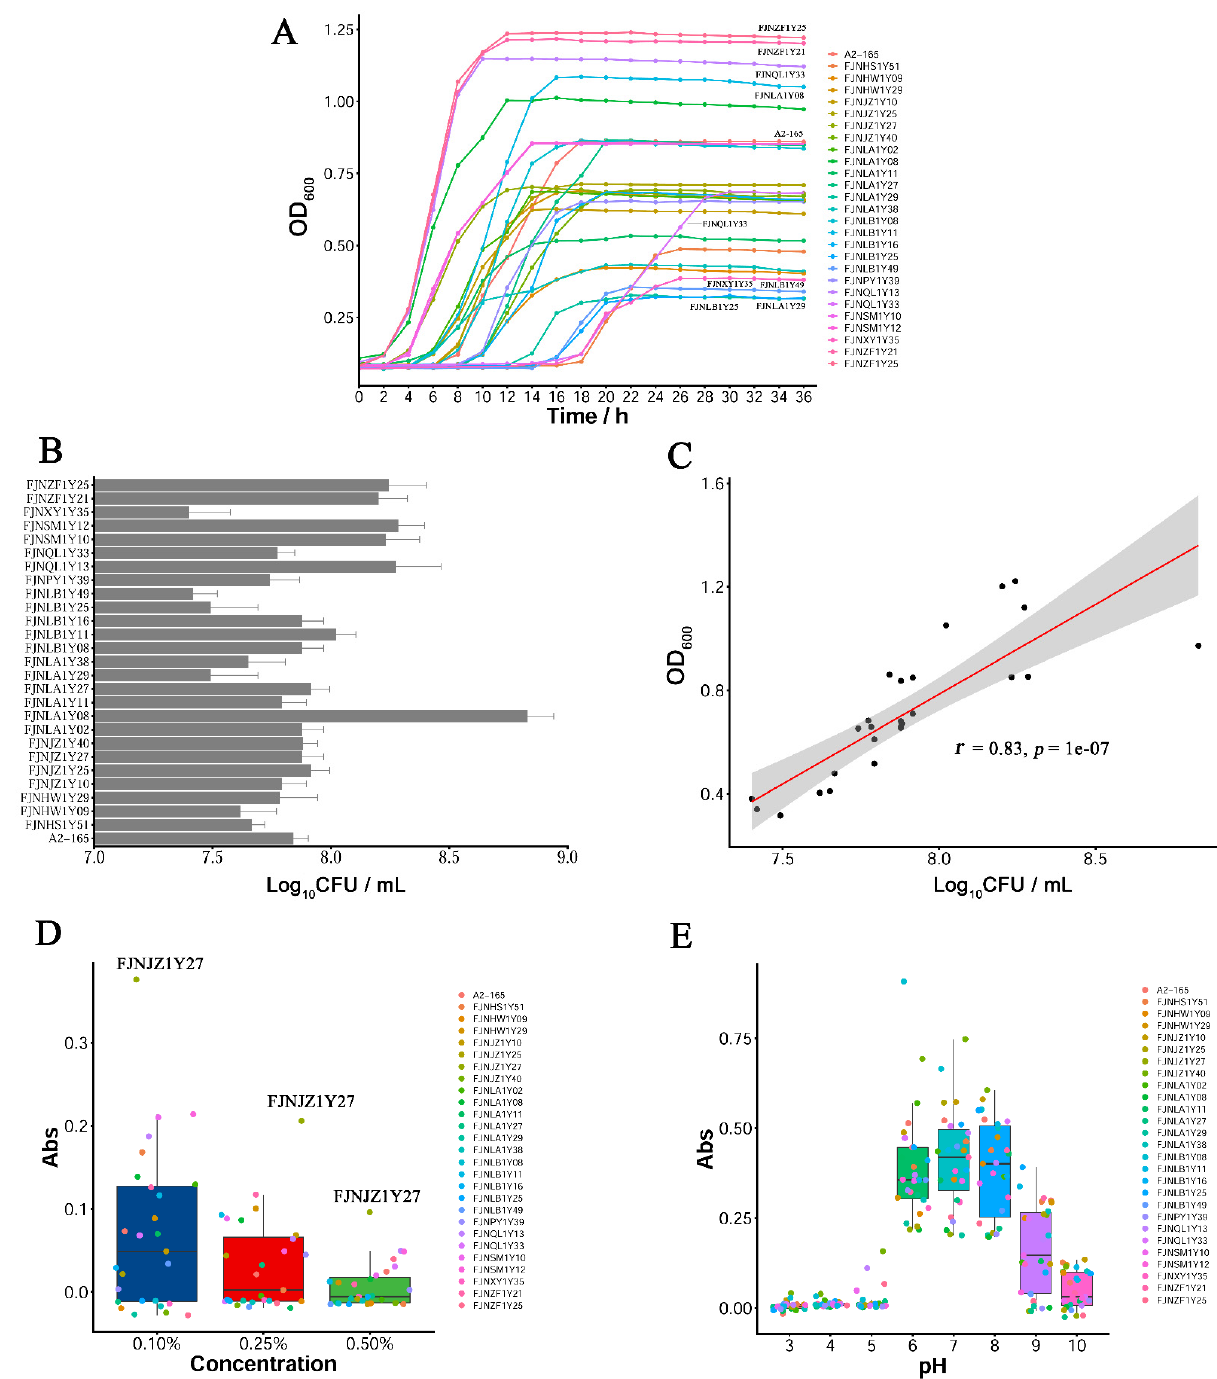
Figure 4. The growth performance of F. prausnitzii strains. ( A ) The growth curves of F. prausnitzii isolates; ( B ) the determination of colony-forming units (CFU) for F. prausnitzii strains; ( C ) the correlation of optical density with log 10 CFU/mL; ( D ) the effect of bile salts on bacterial growth; ( E ) the effect of pH on bacterial growth.